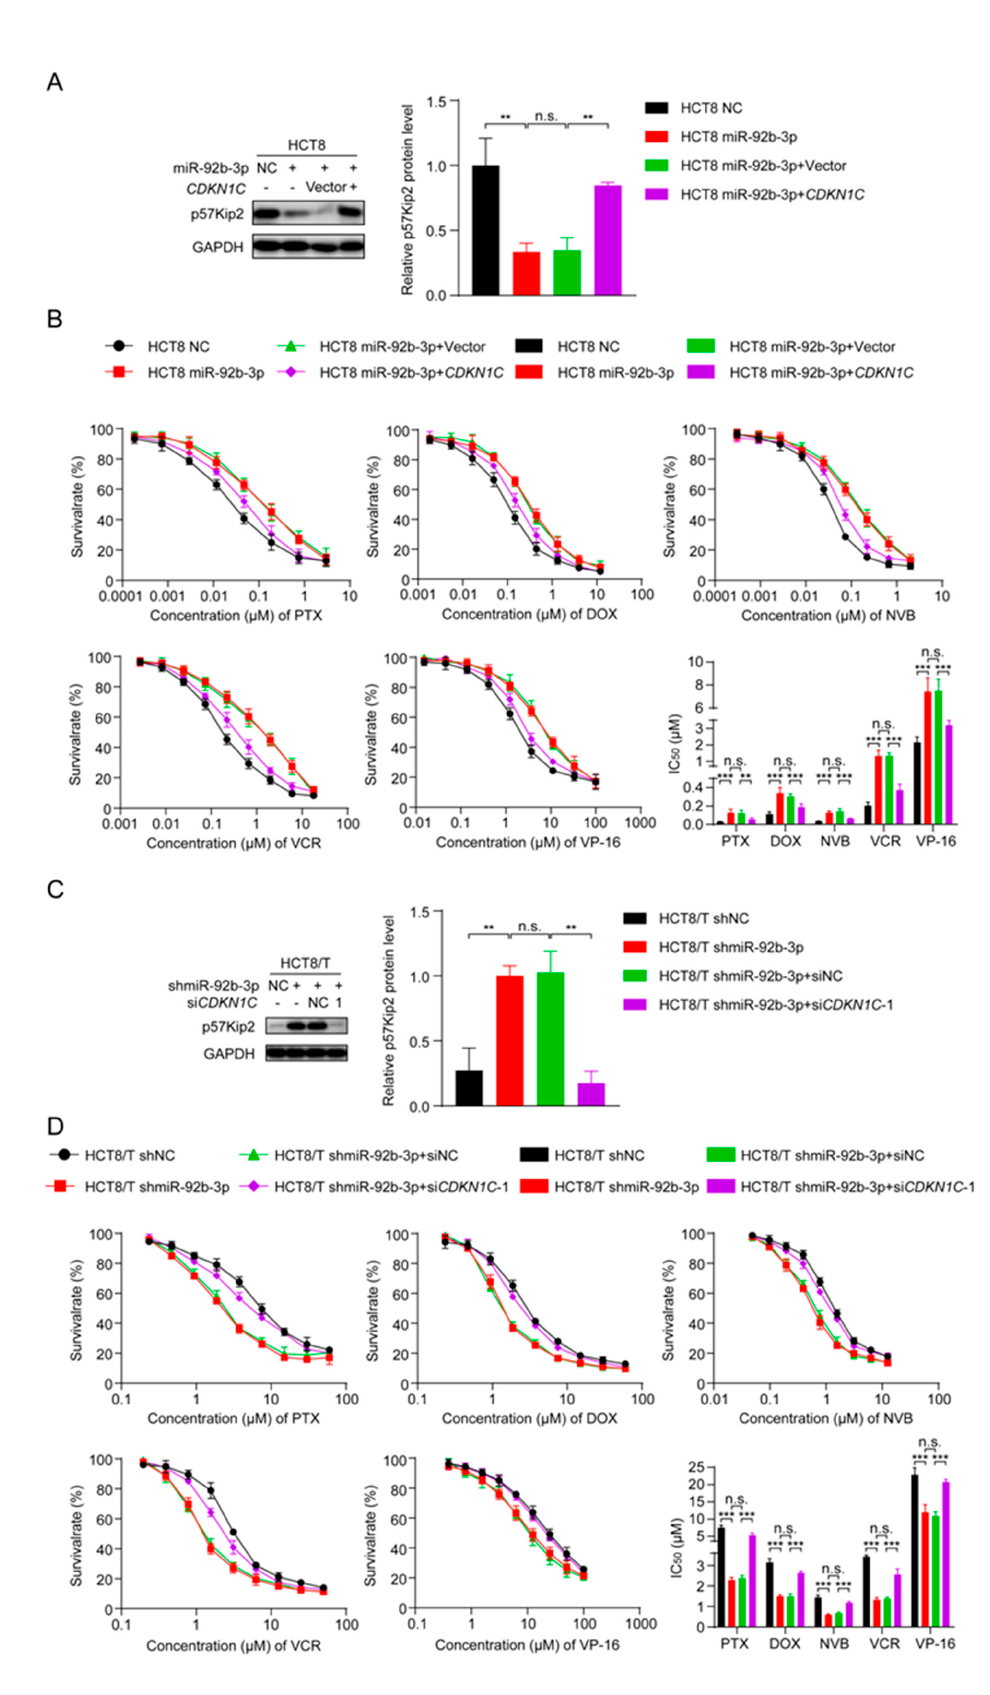
Figure 5. miR-92b-3p regulates the sensitivity of HCT8 and HCT8/T cells to chemotherapeutic drugs by targeting CDKN1C . ( A ) Western blotting analysis of the p57Kip2 expression levels in HCT8 cells transfected with miR-92b-3p or co-transfected with miR- 92b-3p and CDKN1C , and ( C ) in HCT8/T cells transfected with shmiR-92b-3p or co-transfected with shmiR-92b-3p and si CDKN1C- 1 . Detailed information about Western Blot can be found at supplementary materials. ( B ) Overexpression of CDKN1C attenuates the desensitization effect of miR-92b-3p on HCT8 cells to chemotherapeutic drugs, and ( D ) Silencing of CDKN1C reverses the sensitiza-